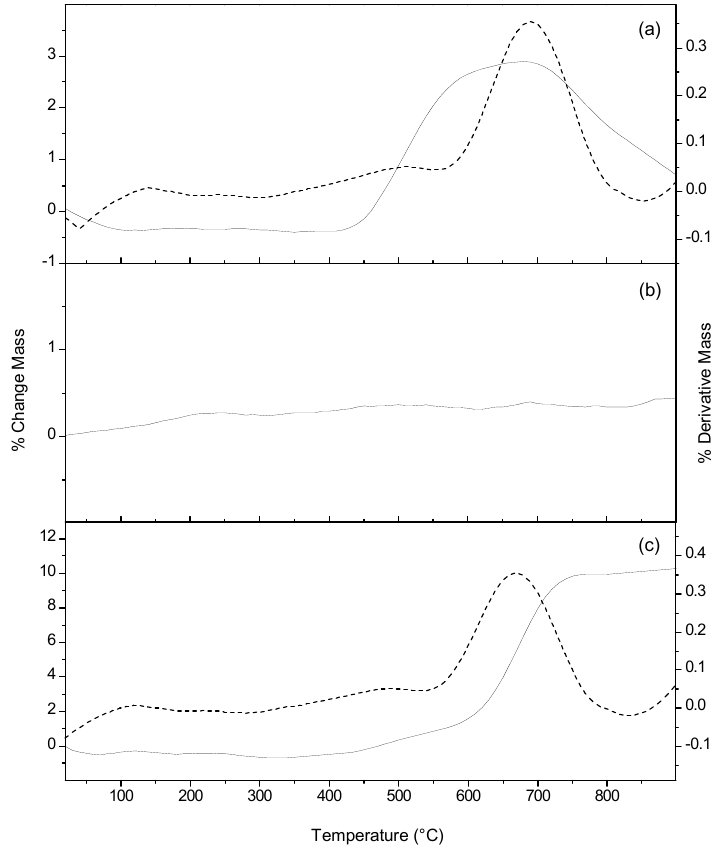
Figure 3. Thermogravimetric and derivative thermogravimetric curves corresponding to different samples calcined in Cl 2 (g): ( a ) Mi, ( b ) microcline and ( c ) calcite.